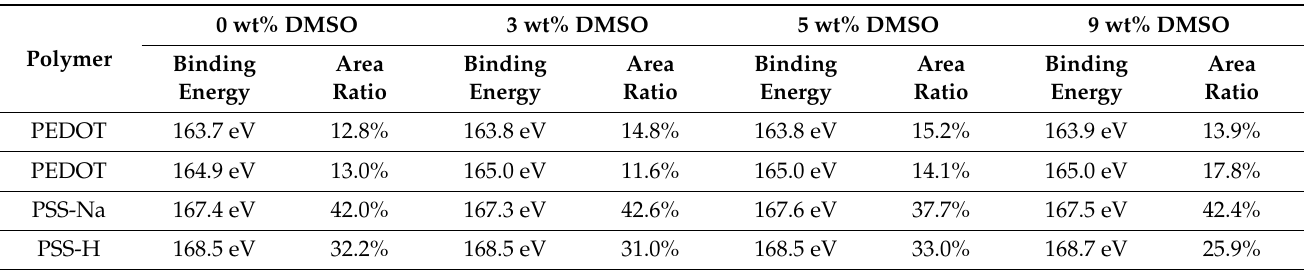
Table 3. Area ratio of various components of the S(2p)